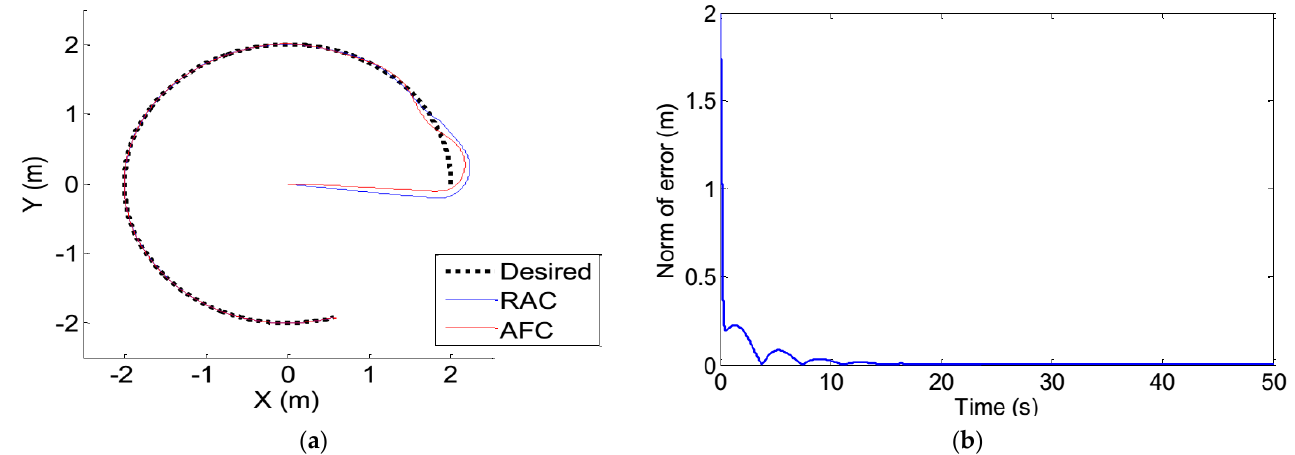
Figure 3. ( a ) The performance of controllers in tracking by moving body ( b ) The tracking error magnitude of the proposed method.